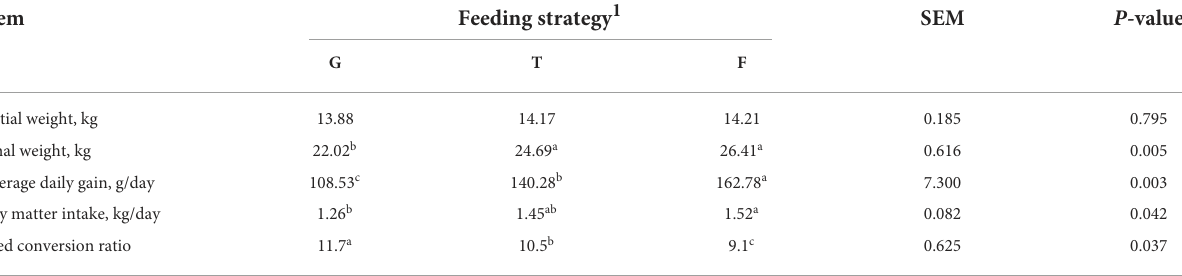
TABLE 2 Effects of different feeding strategies on the growth performance of Gangba